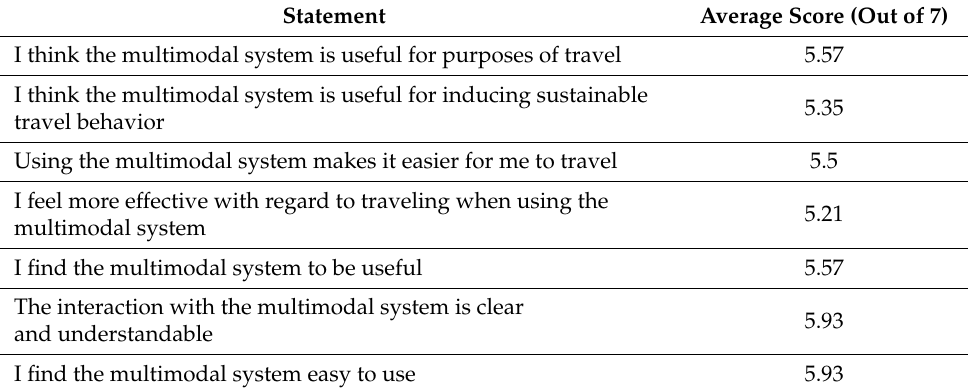
Table 5. Perceived usefulness and usability of the eco-friendly multimodal route guidance (EMRG) system (rating on a 7-point scale, where 1 = strongly disagree and 7 = strongly